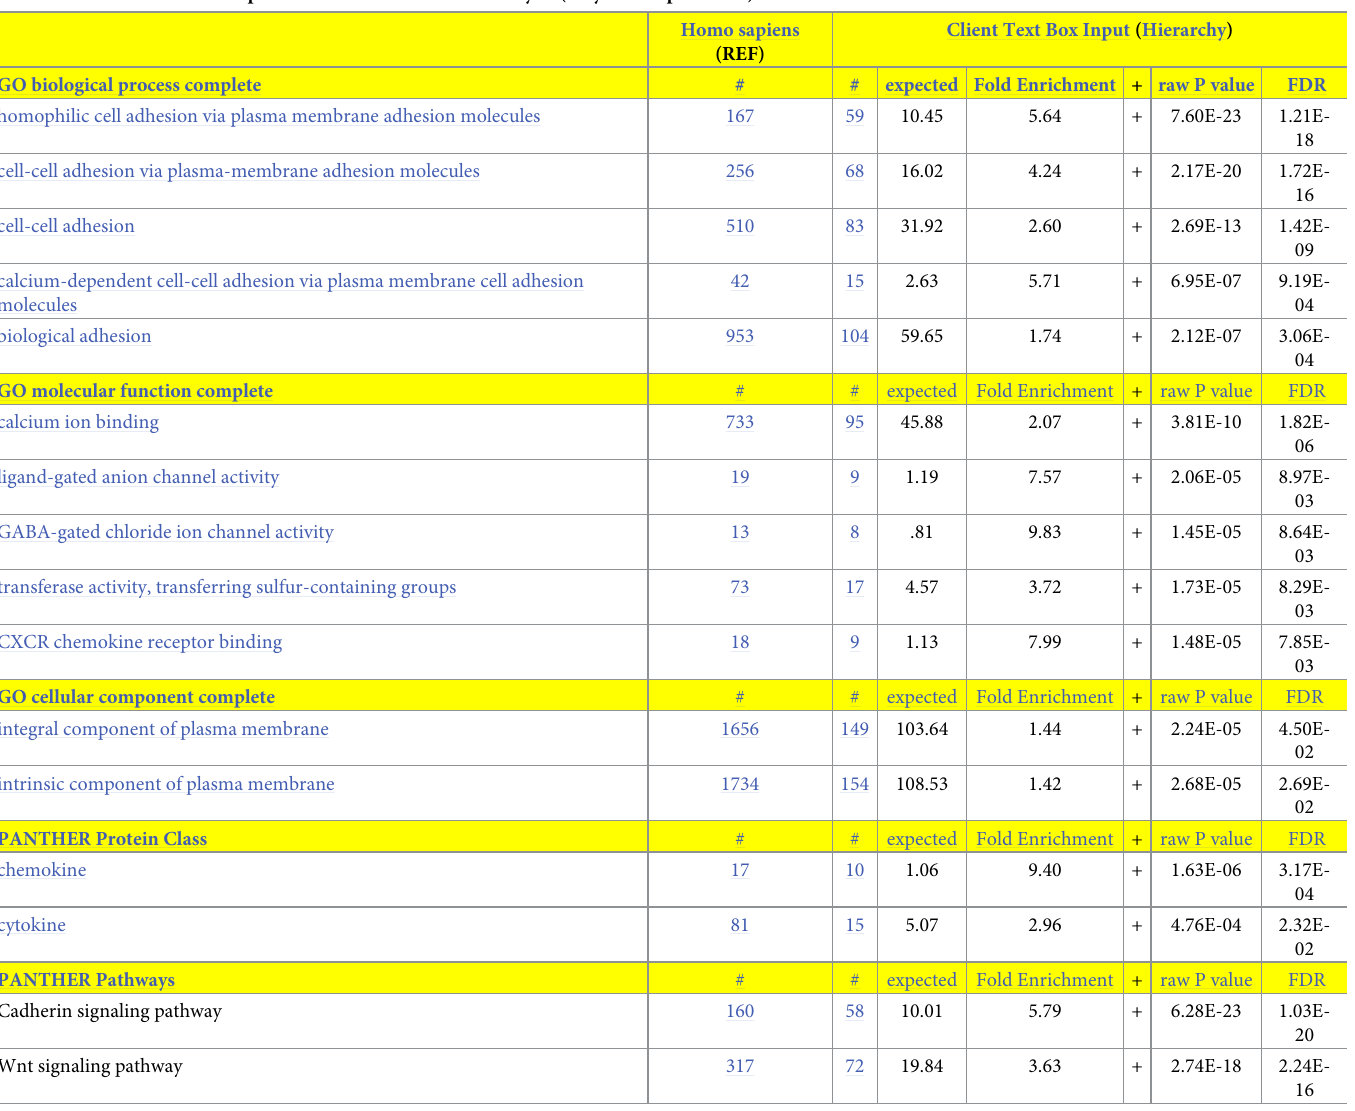
Table 4. Results of the over-representation test of the main analysis (only